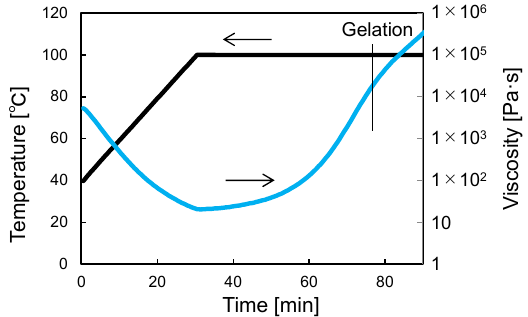
Figure 12. Viscosity of epoxy resin squeezed from T700S/2592 prepreg.